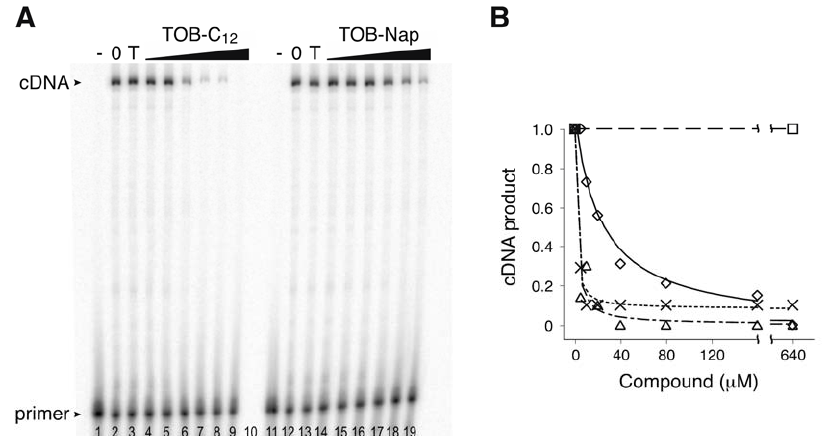
Figure 2. TOB variants inhibit AMV RT. ( A ) An experiment measuring primer extension in the presence and absence of TOB derivatives. Radiolabeled oligonucleotide primer was annealed to an RNA template and added to AMV RT and dNTP substrates in the absence (“0” lanes 2 and 12) or presence of TOB (“T” lanes 3 and 13; 1000 µ M) or its derivatives (TOB-C 12 , TOB-Nap; increasing concentrations as indicated). A control reaction lacking RT (“-” lanes 1 and 11) was included. Following incubation for 10 min at 37 ◦ C, reaction products were resolved by PAGE. ( B ) The relative amount of full-length cDNA product was plotted as a function of compound concentration